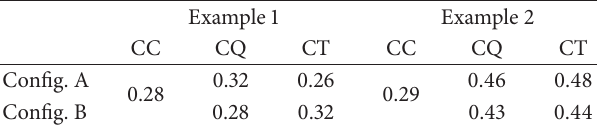
Table 2: Reconstruction